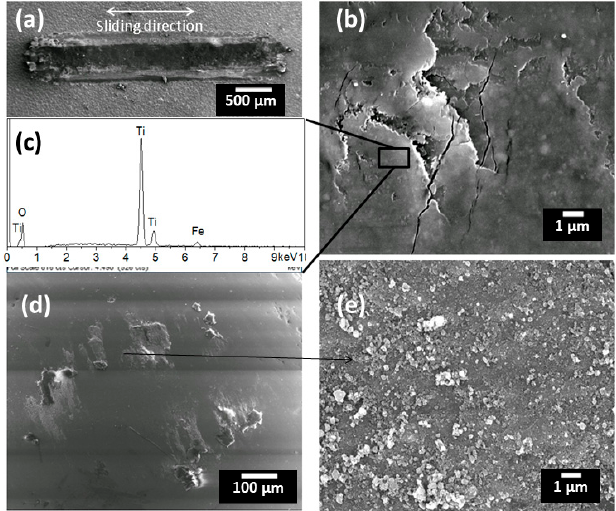
Figure 11. Wear track of coating S2 under ( a ) low magnification and ( b ) high magnification; ( c ) EDS analysis of area in image ( b ); wear scar of counterpart Al 2 O 3 pin under ( d ) low magnification and ( e ) high magnification.